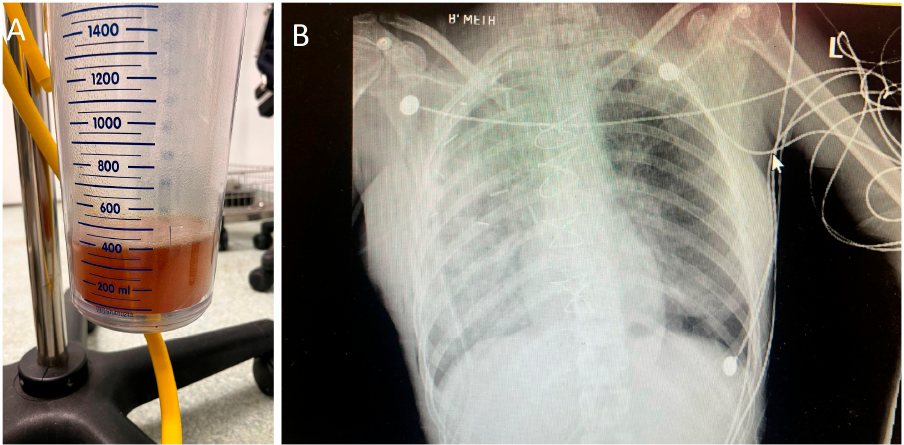
Figure 3. ( A ) Suction contents; ( B ) the patient’s postoperative chest